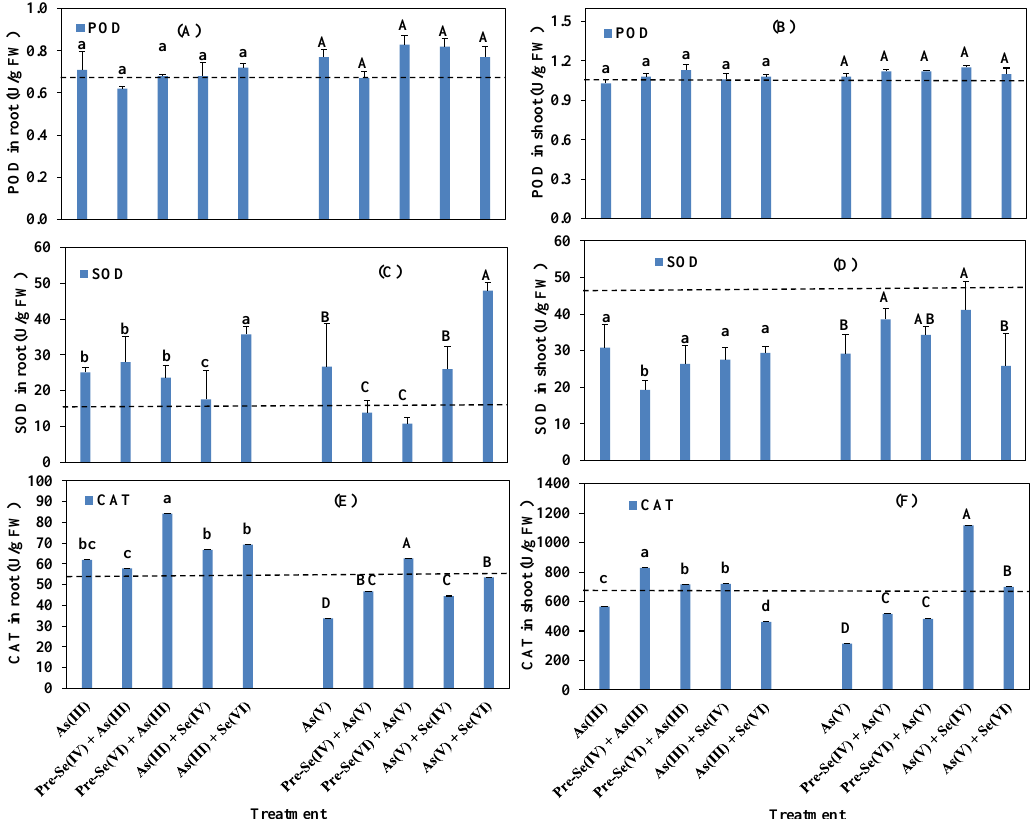
Figure 7. E ff ect of Se pretreatments and co-application on antioxidative enzyme levels in rice roots ( A , C , E ) and shoots ( B , D , F ) exposed to 5 µ M (As and Se). Data are mean value ± SE (n = 3). Discontinuous lines indicate references relative to the control. The letters represent statistically significant ( p < 0.05) differences among treatments.